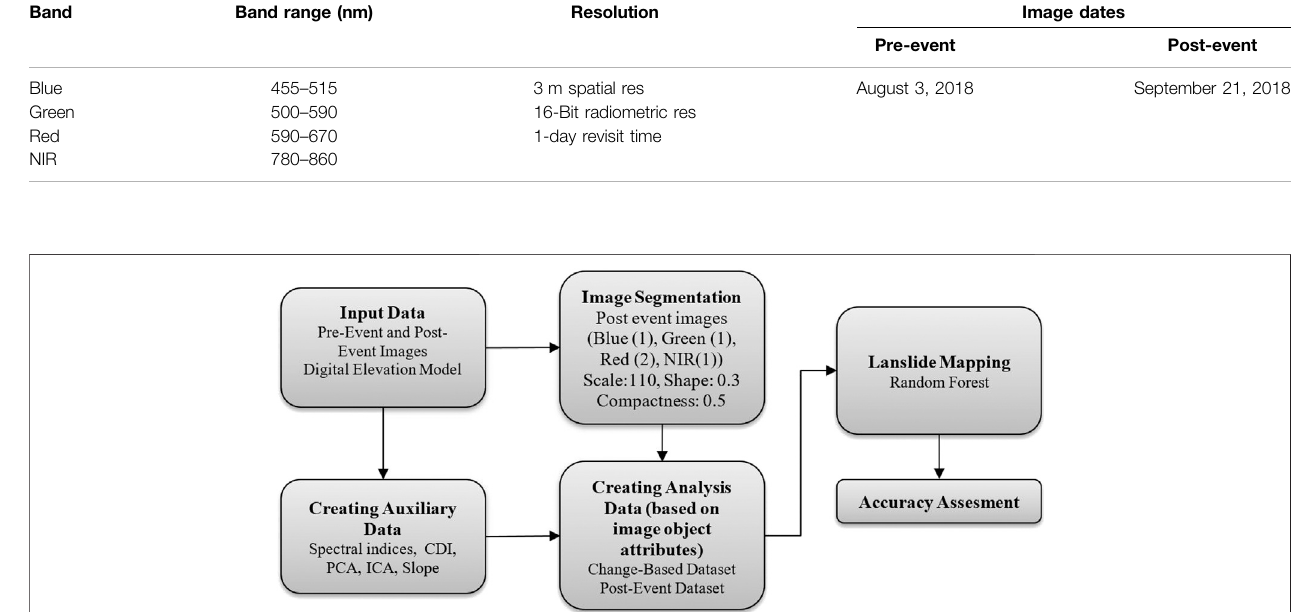
FIGURE 2 | The methodology applied for the rapid detection of earthquake-triggered landslides in the study.